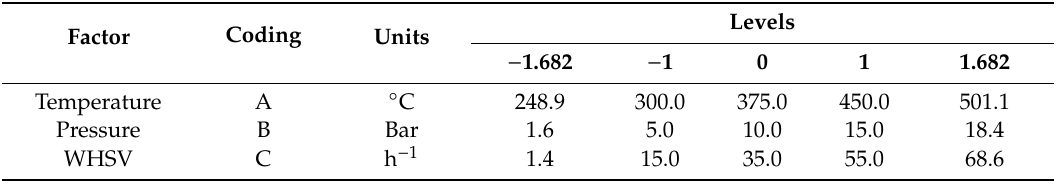
Table 4. Experimental range and coded values of independent variables for the ethanol conversion into hydrocarbons